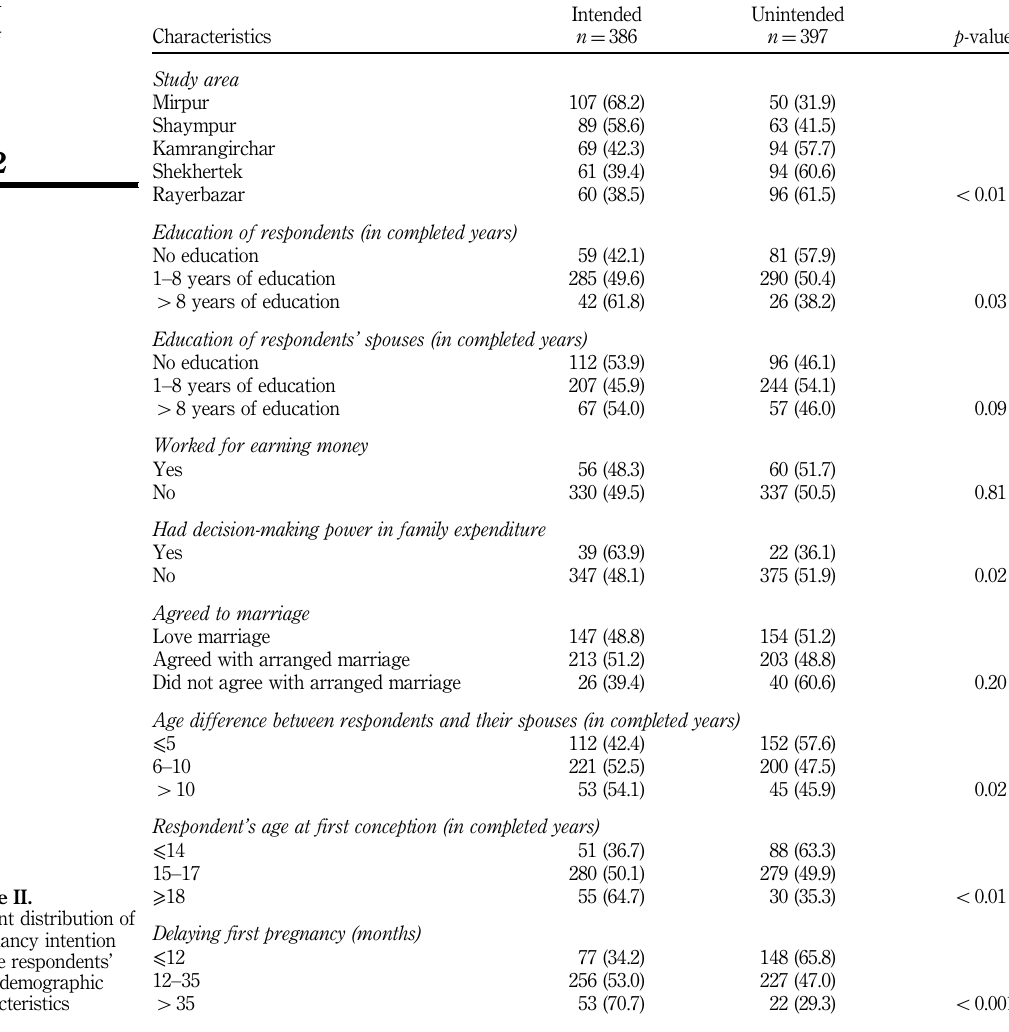
Table II. Percent distribution of pregnancy intention by the respondents ’ socio-demographic